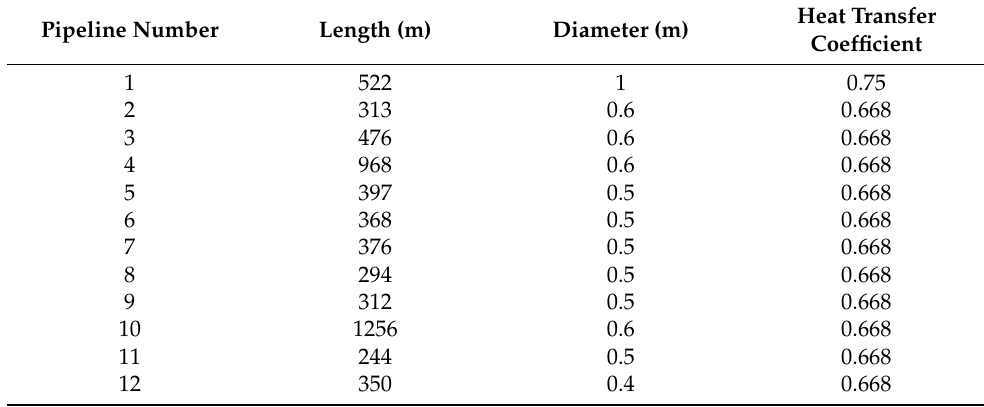
Table A3. Pipeline parameters of the combined electric-steam